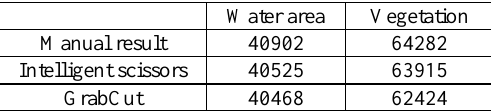
Table 3. The area of vector boundaries